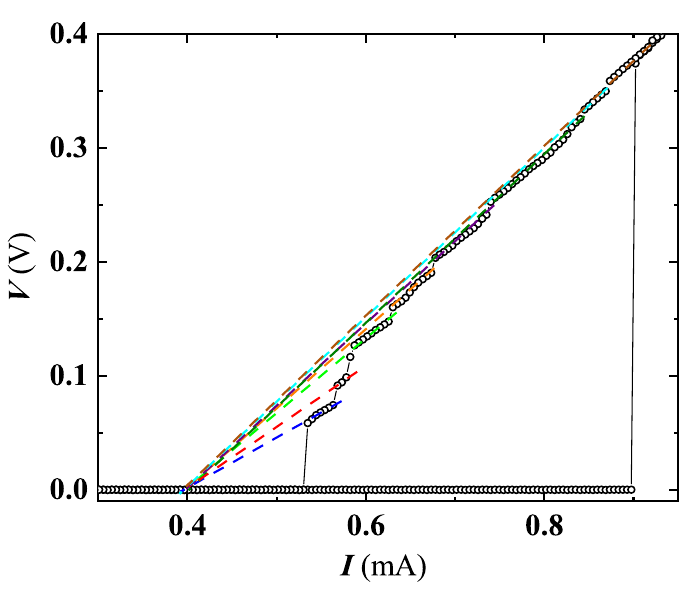
Figure 11. V-I curve at T = 7.48 K is shown for SR5, in which an intercept (represented by dotted lines of different colors for different PSL) on x-axis converge towards a well-defined value of the excess current of I ex = 0.38